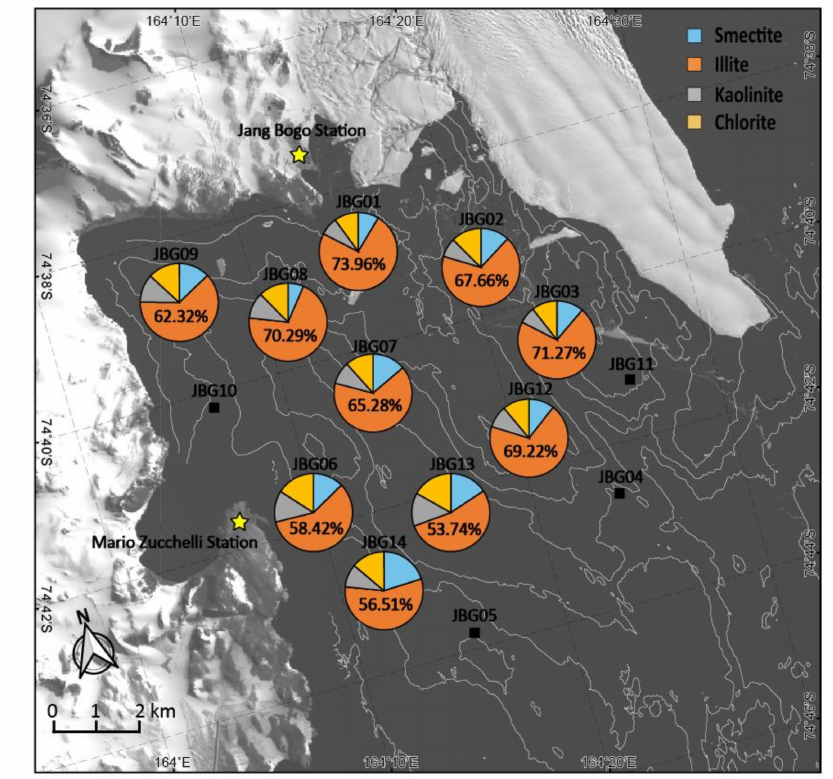
Figure 4. Average clay mineral composition of surface sediments collected from Terra Nova Bay,